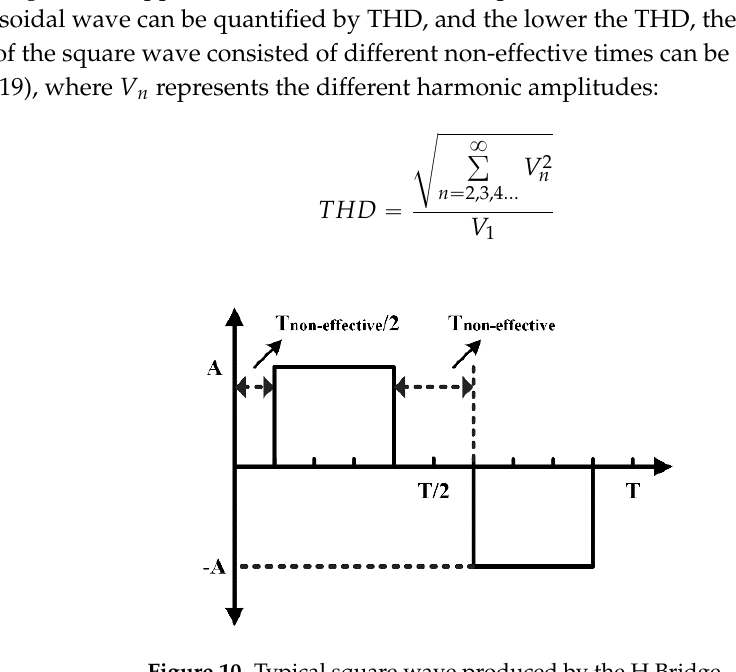
Figure 10. Typical square wave produced by the H Bridge.